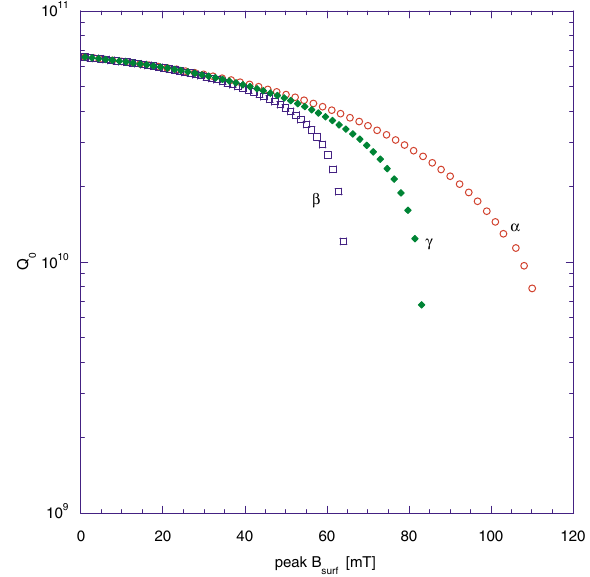
FIG. 15. (Color) 2 GHz double spherical cell cavity. Curve ( (cid:7) ): 2 mm bulk Nb, bath cooled. Curve ( (cid:11) ): 2 mm bulk Nb, pipe cooled with 2 pipes ; (cid:3) 3 cm , cavity surface coverage (cid:15) 18% . Curve ( % ): Nb on Cu (5 mm thick), pipe cooled with the same (cid:3) 1 : 8 K for all configuration as in ( (cid:11) ). T l He